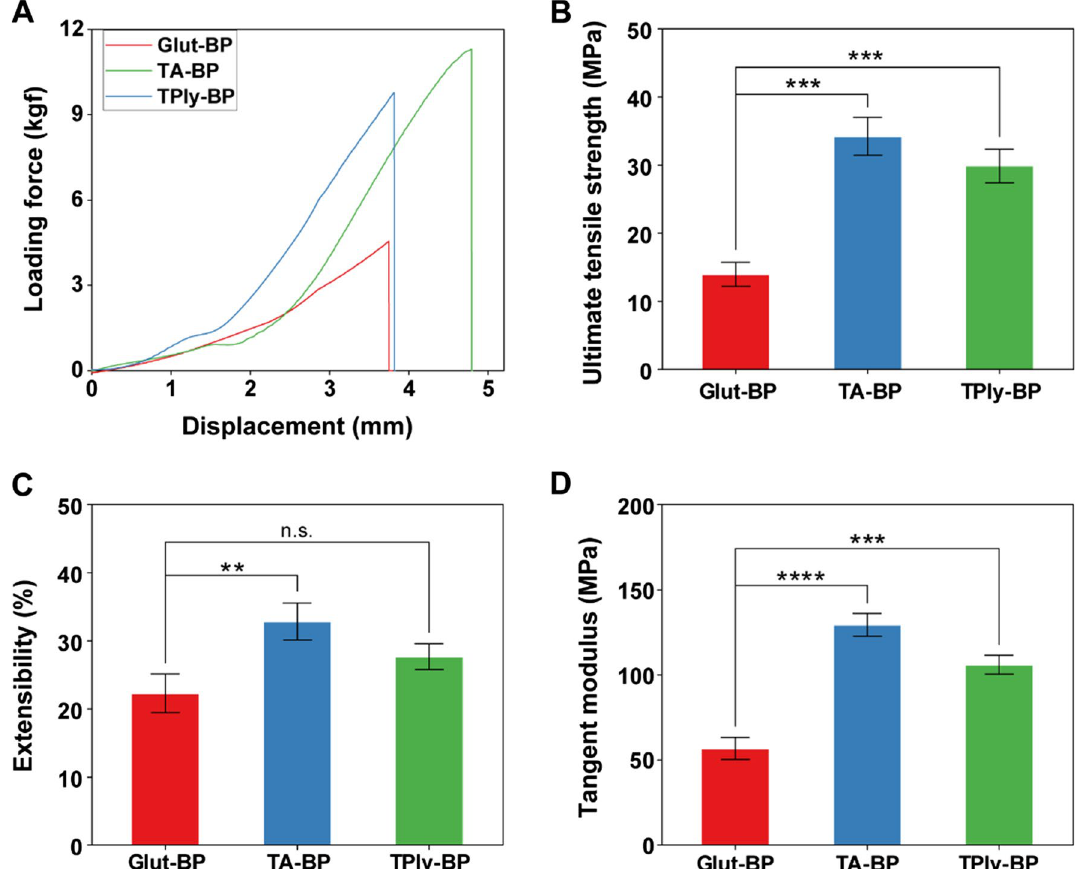
Fig. 3 Mechanical properties of TPly-BP. A Tensile displacement and load curves, B ultimate tensile strength, C extensibility and D tangent modulus of Glut-BP, TA-BP and